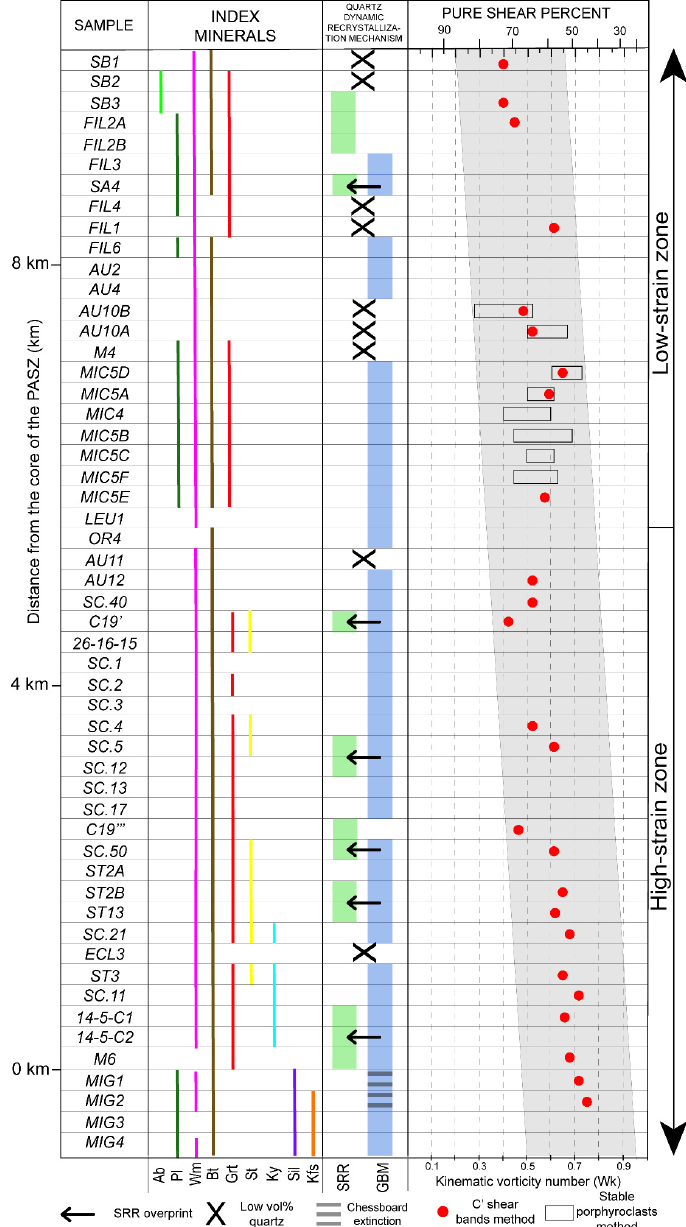
Figure 4. Summary diagram where metamorphic paragenesis, quartz recrystallization mechanism, vorticity number and the related percentage of pure shear are shown and are plotted against the distance from the core of the PASZ. SRR = subgrain rotation recrystallization, GBM = grain boundary migration. The distribution of the samples shows increasing Wk values (i.e., increase in the simple shear component) toward the shear zone (trend: grey area).